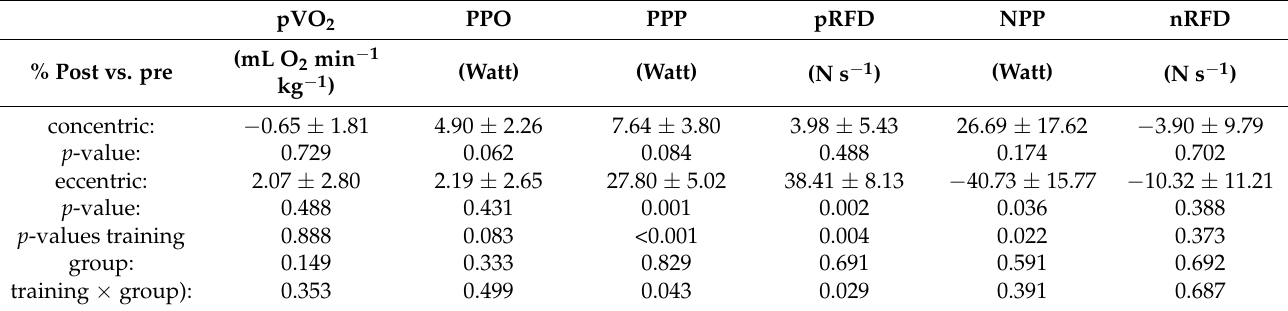
Table 5. Alterations in performance with interval-type pedaling training. Top) Mean ± SE of the post vs. pre difference in percent for parameters of aerobic and anaerobic performance with interval type training, and bottom) p -values for the single and interaction effect of interval ‘training’ × the contraction group’. Abbreviations: nRFD, rate of negative force development; pRFD, rate of positive force development. pVO 2 , peak VO2max. Repeated-measures ANOVA with post-hoc test of least significant